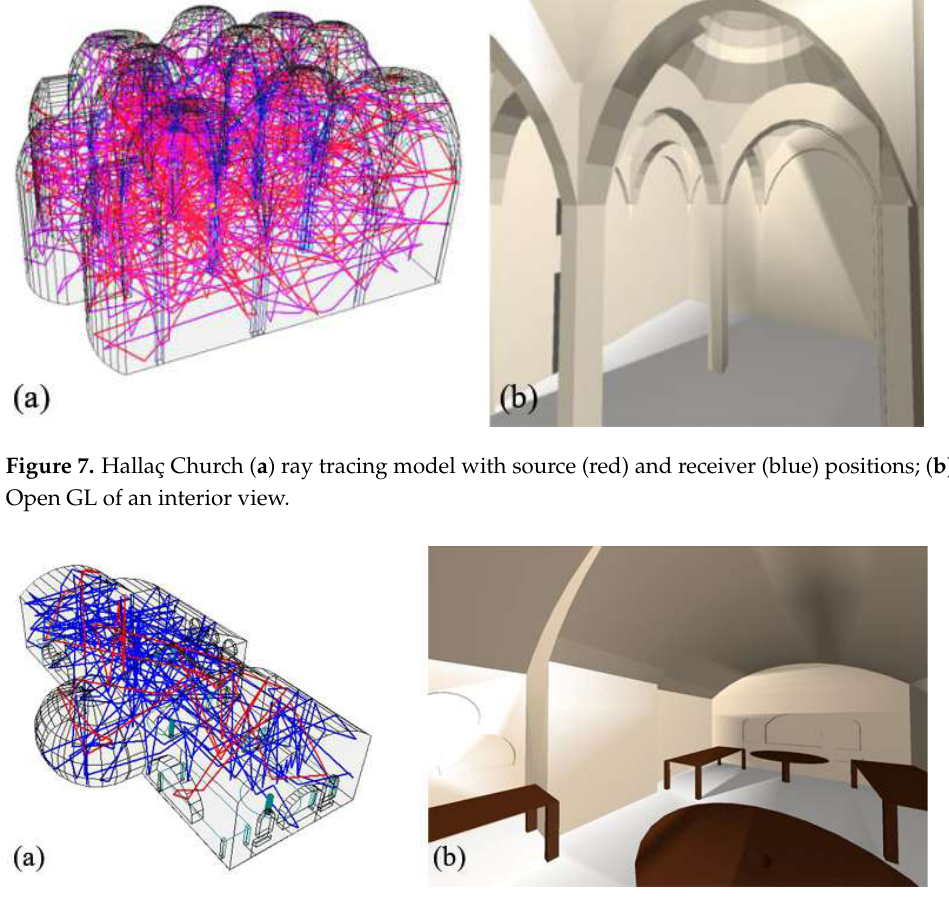
Figure 8. Avanos Dining Hall ( a ) ray tracing model with source (red) and receiver (blue) positions; ( b ) 3D Open GL of an interior view.